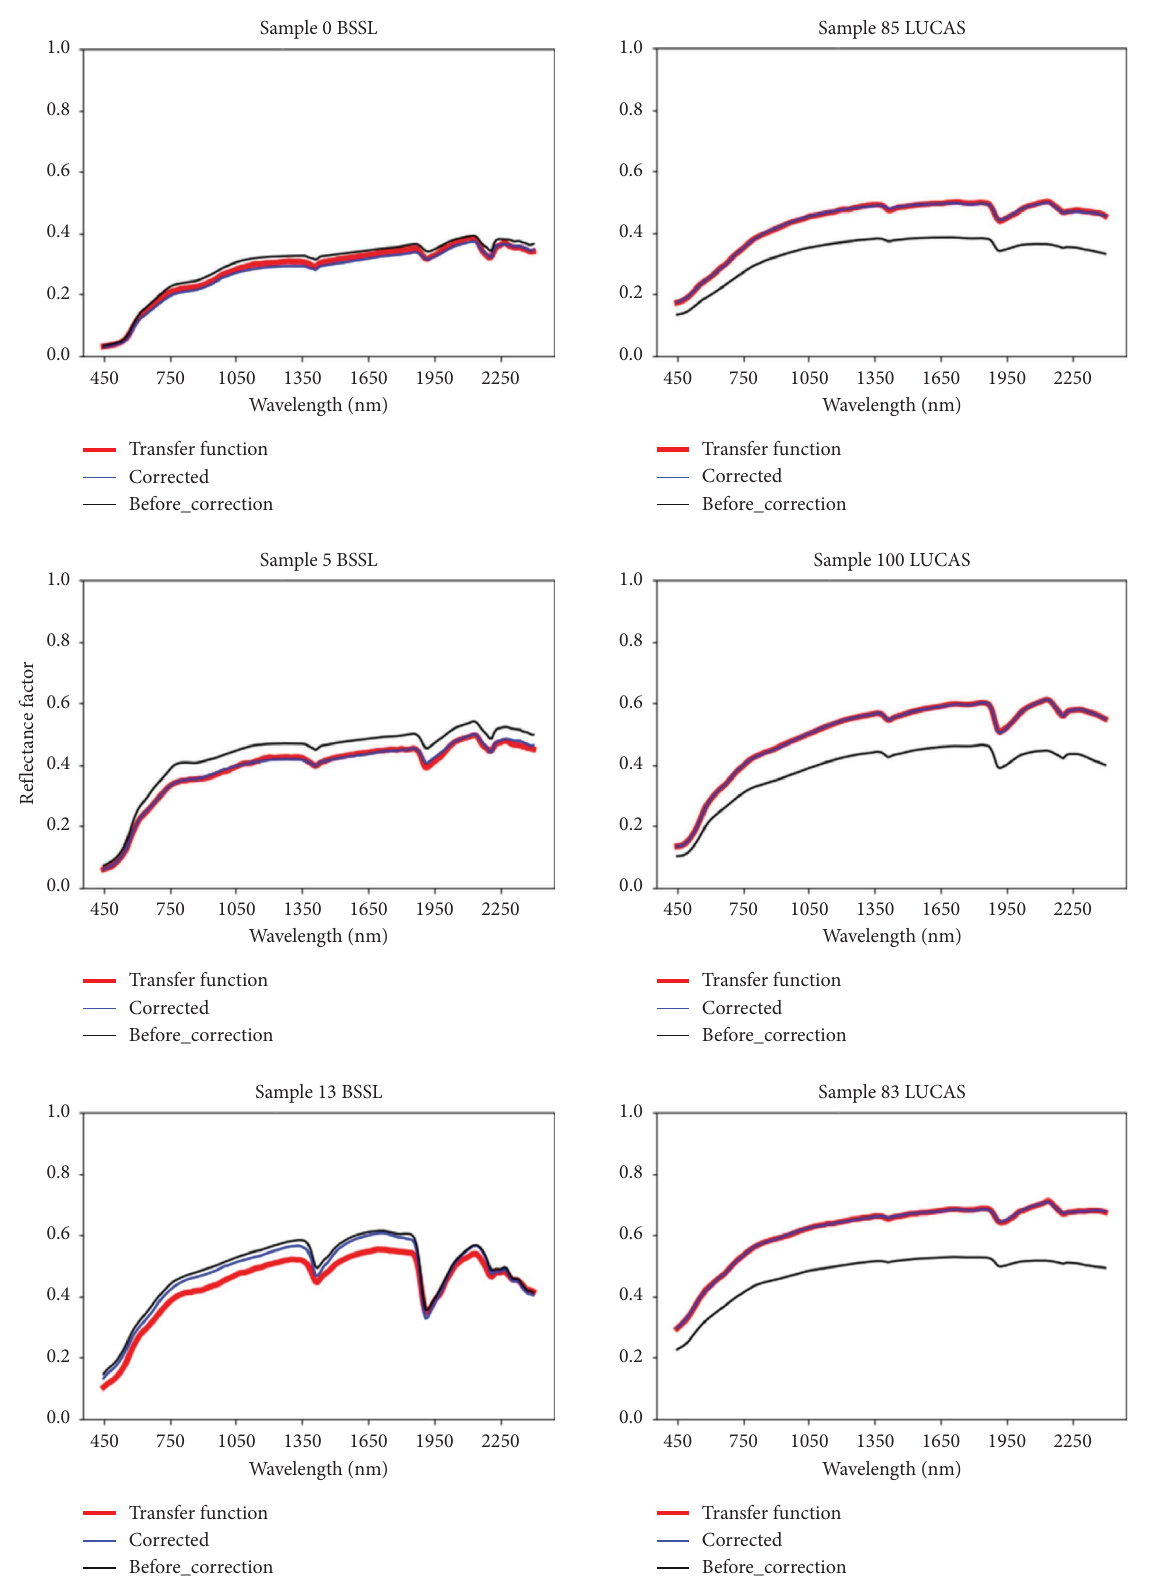
Figure 7: Some examples after applying TFs2 on old–original measurements of the TFs2: blue—ISS correction of the new measurements; red—TFs2 (trained with the old–original measurements); black—measured spectra before TFs2